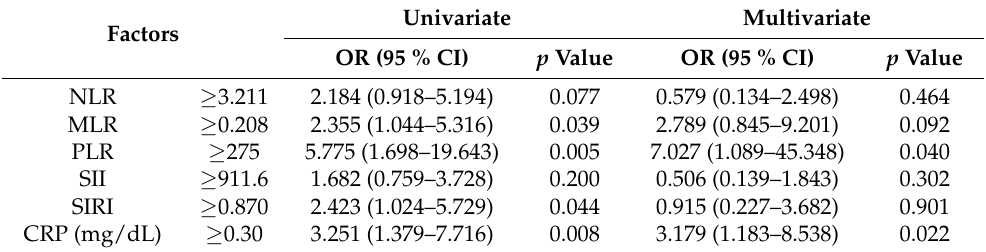
Figure 2. Spearman’s correlation coefficients among four peripheral blood parameters and six systemic inflammatory markers. Blue boxes indicate positive correlations, and red boxes indicate negative correlations.